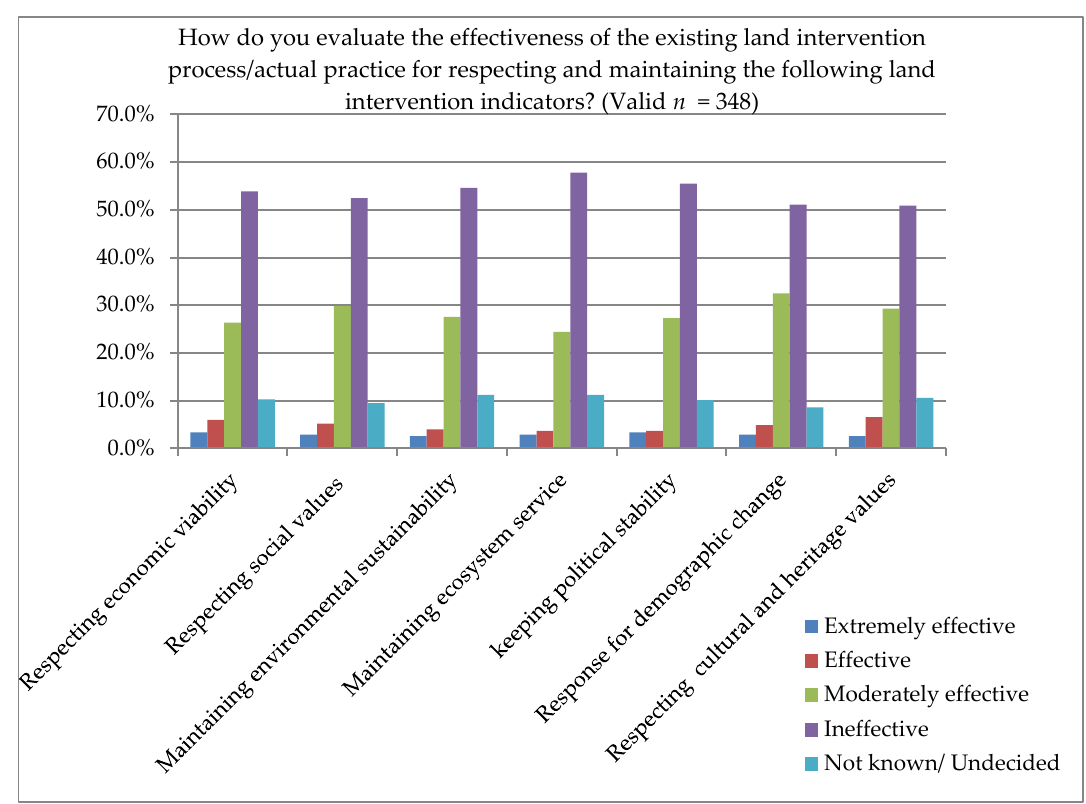
Figure 7. Effectiveness of the existing land intervention practices.